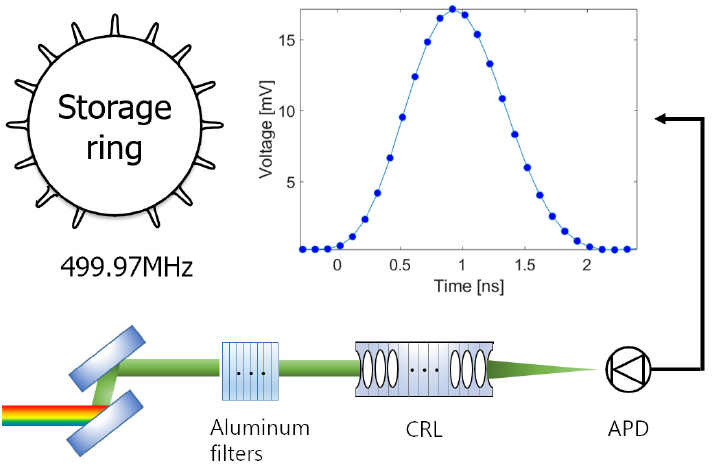
Figure 1. Sketch of the data acquisition scheme. 10 keV X-ray radiation is delivered from the Silicon (111) monochromator and focused on the 0.5 mm APD sensor by using a set of compound refractive lenses (CRL). The X-ray flux for the measurement is controlled by using varying combinations of aluminum filters positioned before the CRL. The waveforms are acquired by feeding the APD signal to the